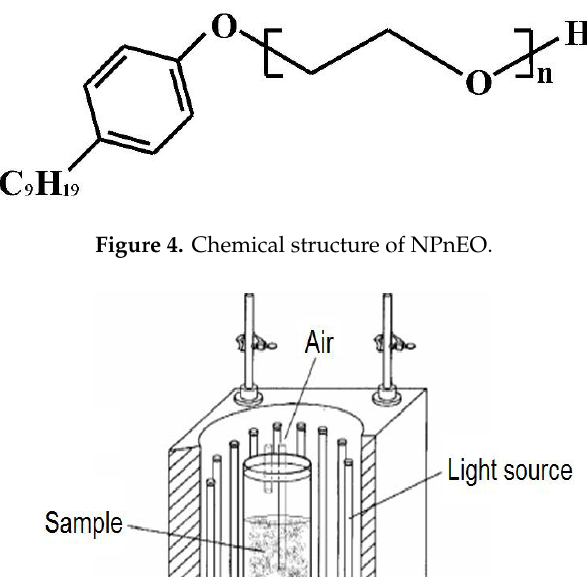
Figure 6. ( a ) Effect of catalyst dosage on the degradation of NP9EO (G/N = 0.3, NP9EO = 100 mg/L, H 2 O 2 = 0.05 mM (1000 mg/L), pH = 6), ( b ) Effect of increasing H 2 O 2 concentration on NP9EO degradation. Data presented are the average of duplicate experiments with relative standard deviation. (G/N = 0.3, NP9EO = 100 mg/L, pH = 6, dosage = 0.3 g/L). In addition, the effects of hydrogen peroxide (H 2 O 2 ) concentration (0–0.1 M) on photocatalytic oxidation were investigated. The experimental results indicated that, initially, on increasing the H 2 O 2 concentration up to 0.05 mM for nano-Cu catalysts, the highest exhibited NP9EO and TOC removal efficiencies were 83.1% and 70.6%, respectively; the rate of degradation increased due to the availability of the hydroxyl radical (·OH) by the decomposition of more H 2 O 2 molecules [36]. Subsequently, NP9EO and TOC removal efficiency gradually decreased (70.3% and 60.1%, respectively) with increasing H 2 O 2 concentration above 0.08 mM (Figure 6b). The propagation step in the oxidative cycle is hindered by an excess of H 2 O 2 , which scavenges the ·OH radicals in the